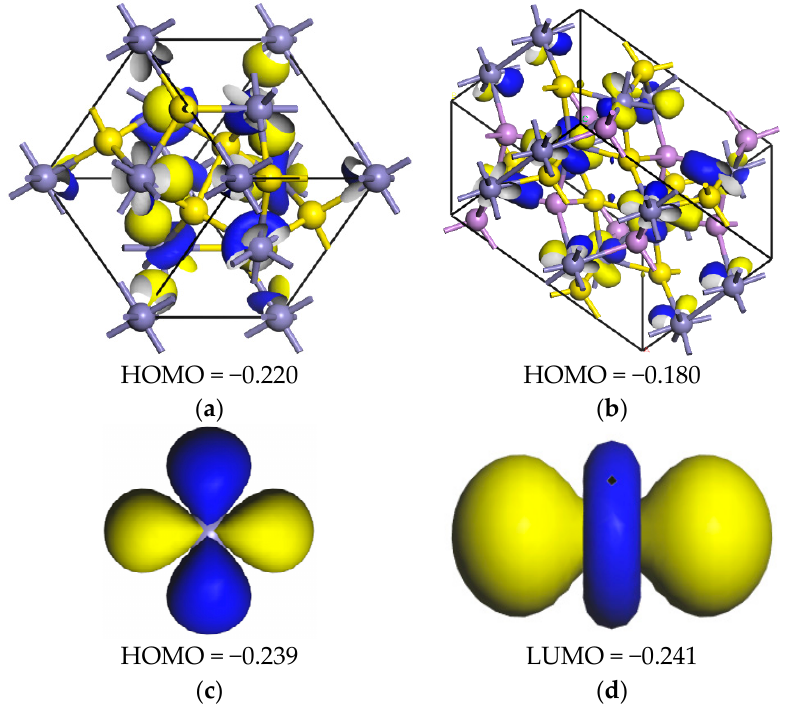
Figure 7. Crystal structure and highest occupied molecular orbital (HOMO) (green and yellow iso surface) of pyrite ( a ), arsenopyrite ( b ), and Fe 2+ ( c ) and lowest unoccupied molecular orbital (LUMO) of Fe 3+ ( d ) (blue ball for Fe atom, yellow ball for S atom, and purple ball for As atom).